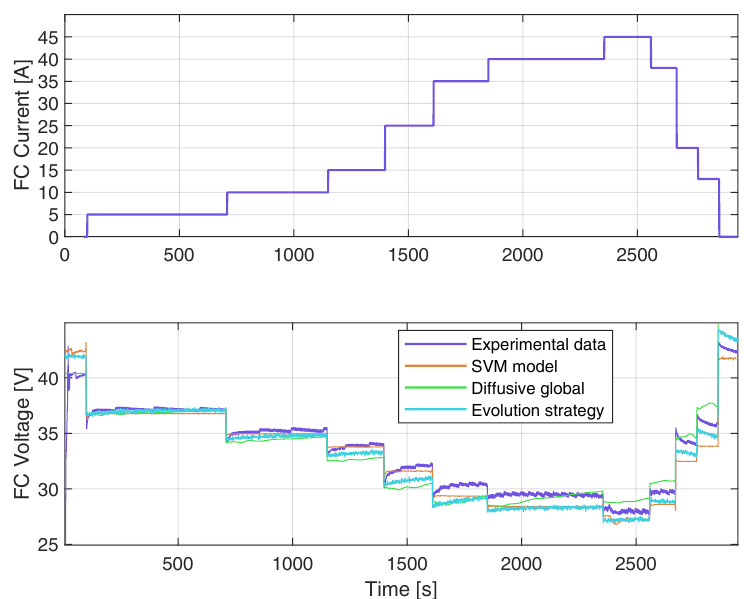
Figure 9. Real data used for validating: current load profile ( above ), and output voltage simulated with parameters estimated by means of ES, the diffusive global model, and the SVM approach ( below